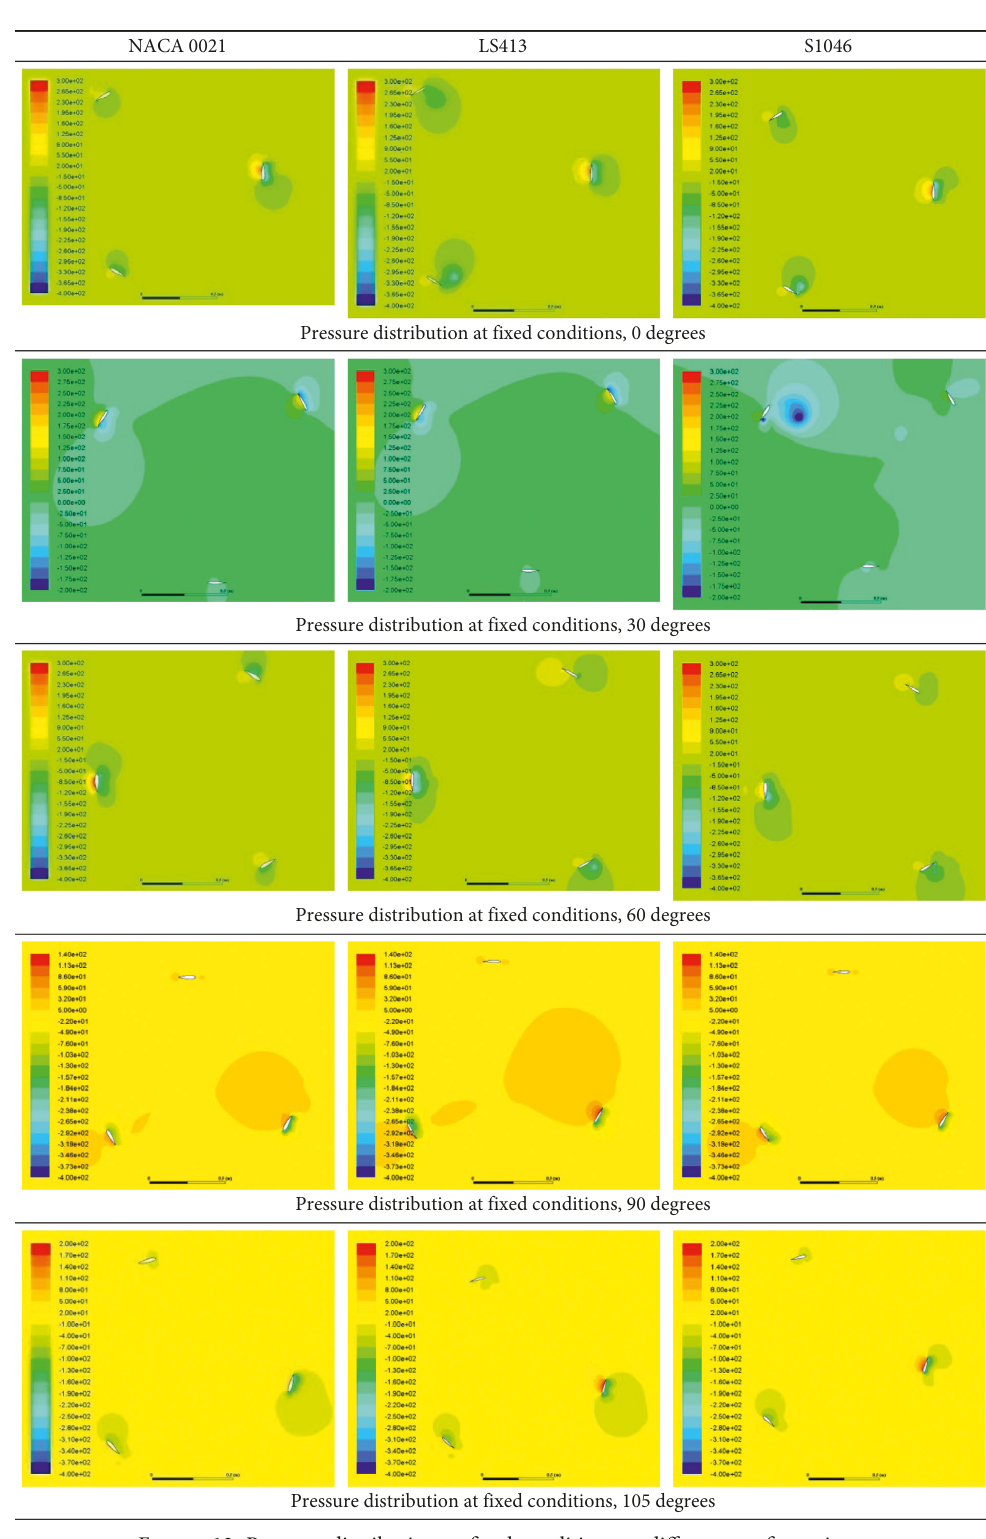
Figure 12: Pressure distribution at fixed conditions at different